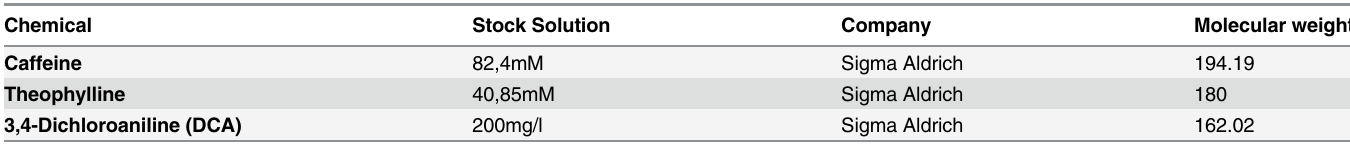
Table 5. Chemicals used to intoxicate embryos to build the validation